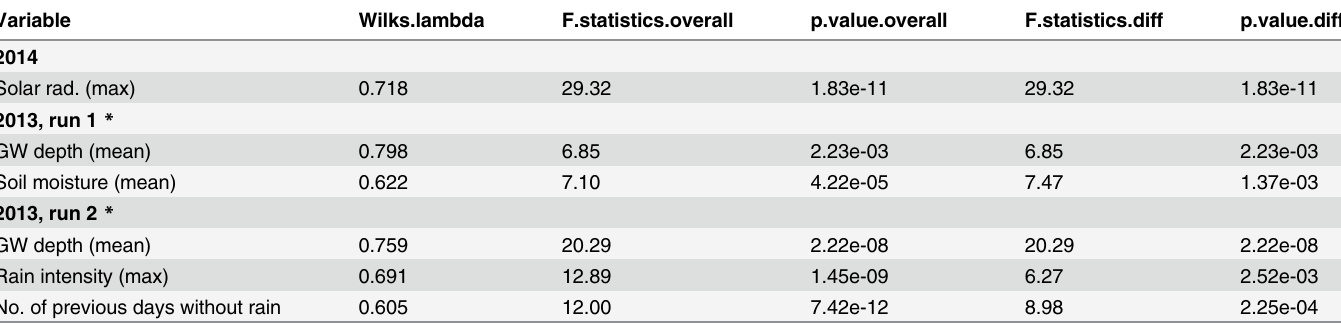
Table 2. Drivers selected to explain the clusters, using Wilk ’ s Lambda